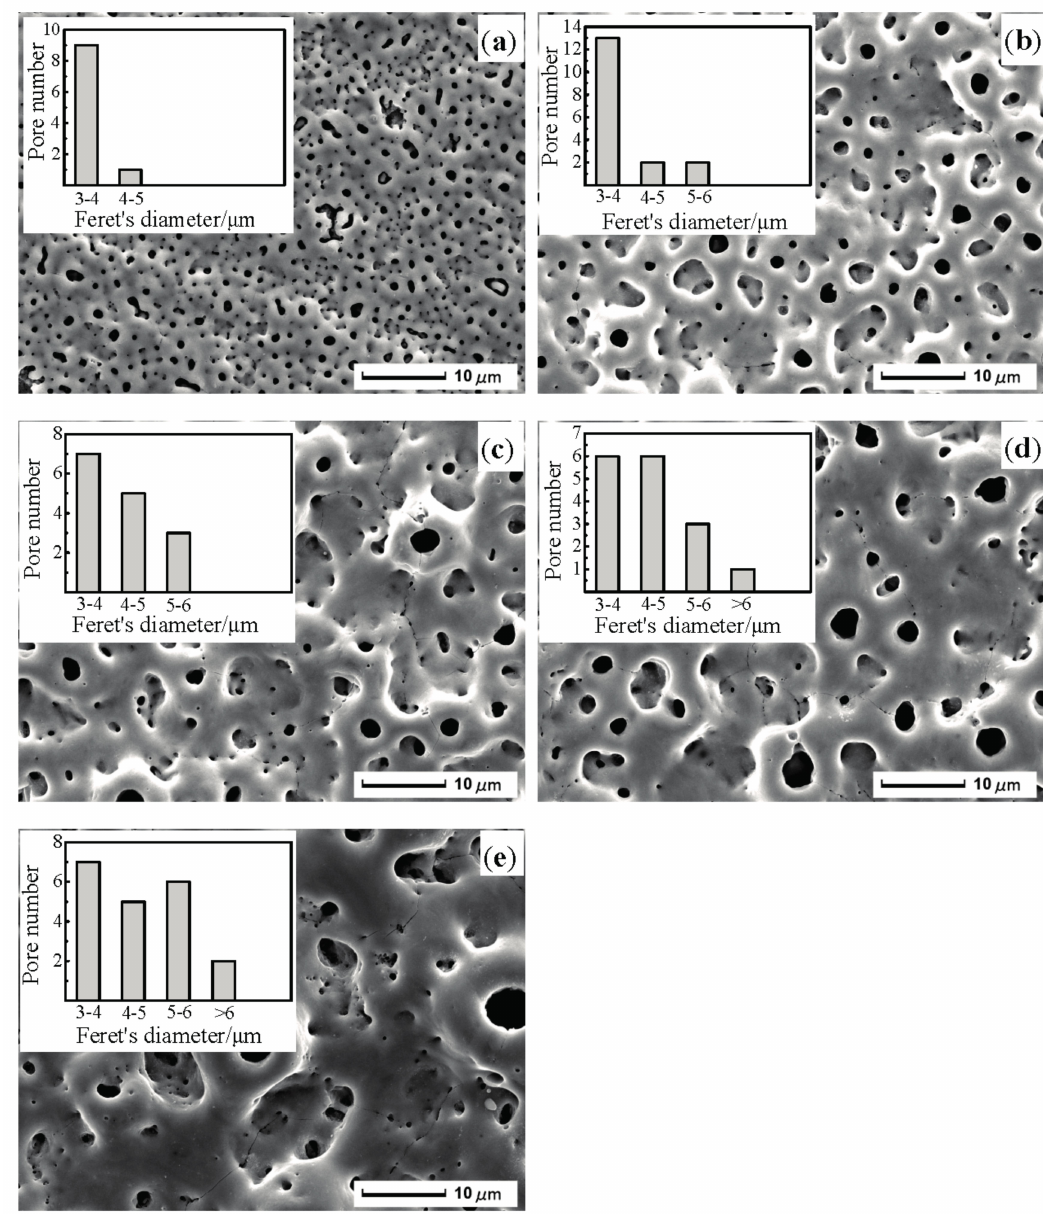
Figure 1. SEM (scanning electron microscope) morphology and statistical data of micropores with diameter exceeding 3 µ m of the MAO (micro-arc oxidation) coating at different oxidation times: ( a ) 3 min; ( b ) 6 min; ( c ) 9 min; ( d ) 12 min; and ( e ) 15